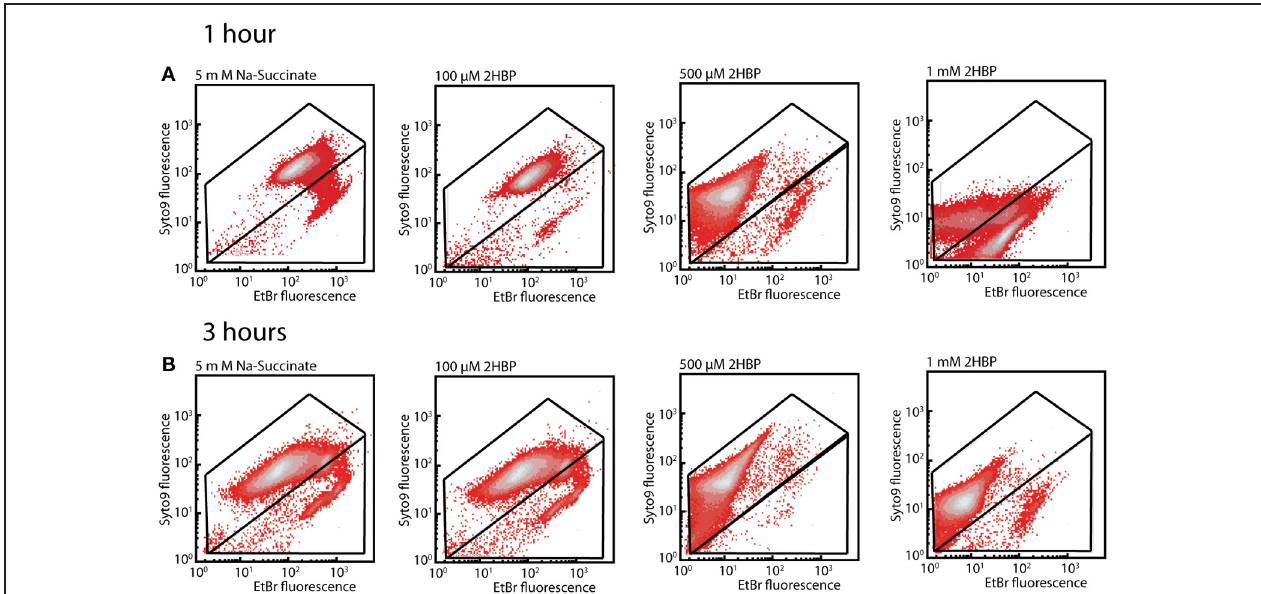
FIGURE 3 | Membrane damage in P. azelaica HBP1 wild-type cells as a function of exposure to 2-HBP. (A) Exponentially growing cells on 5mM sodium succinate exposed or not to 2-HBP at 100 μ M, 0.5 and